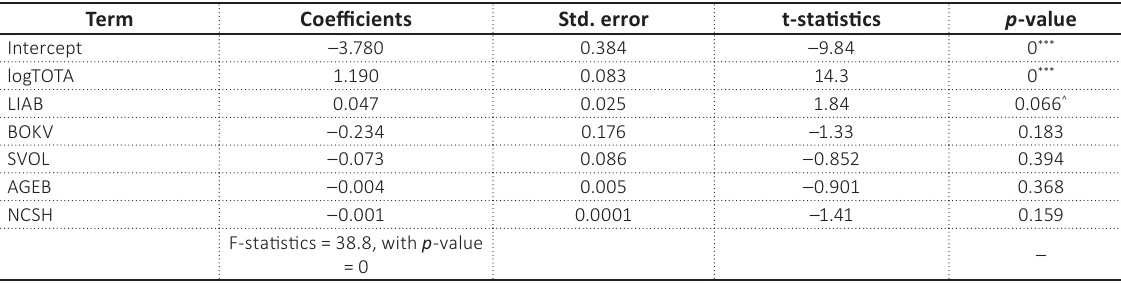
Table 2. Linear regression analysis for EPS model